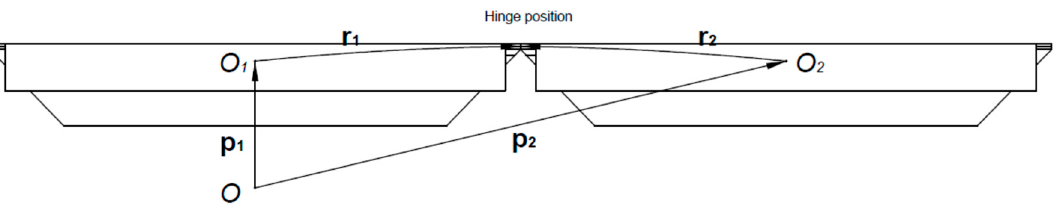
Figure 1. The connected breakwaters in the initial position.